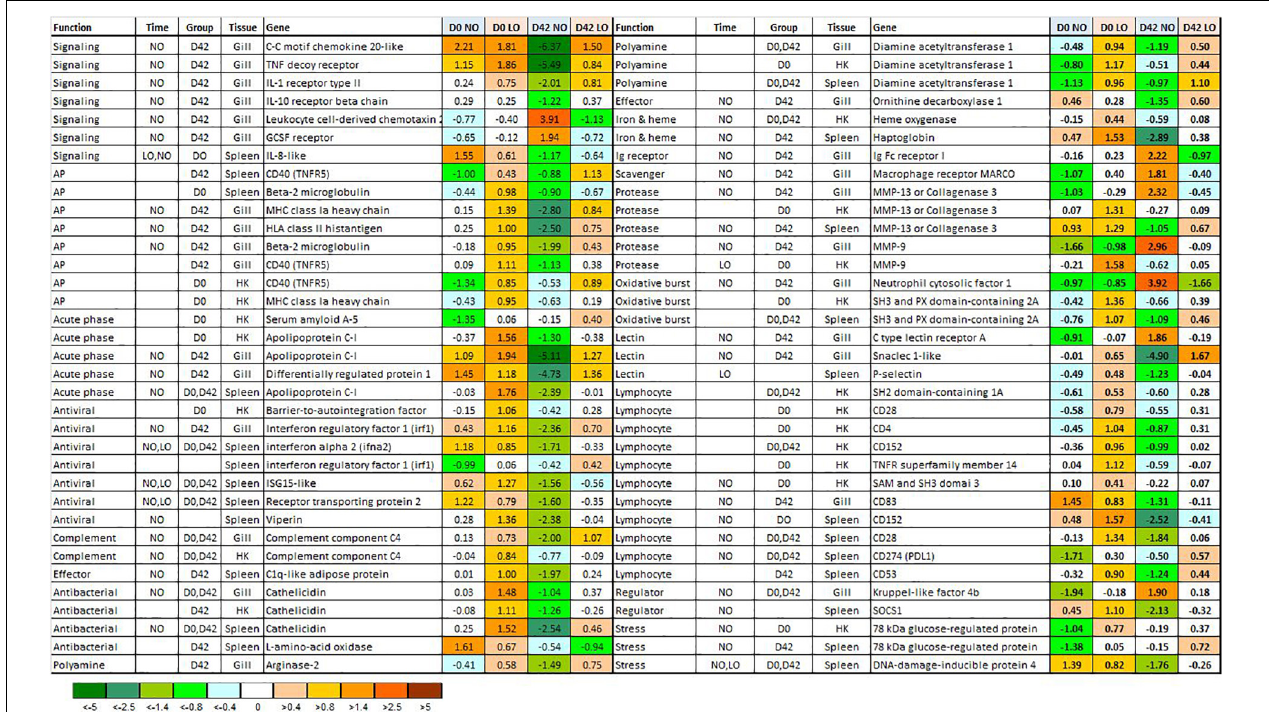
FIGURE 3 | Differentially expressed genes BioMark HD assay. Data ( (cid:49)(cid:49) Ct) are normalized so that the mean value for each gene is equal to zero. Significant differences between days 0 and 42 (beginning and end of light stimulation) and the treatment groups are denoted in columns Time and Group. NO, LO – normal and low dissolved oxygen. NO, LO – groups maintained at normal and low dissolved oxygen.